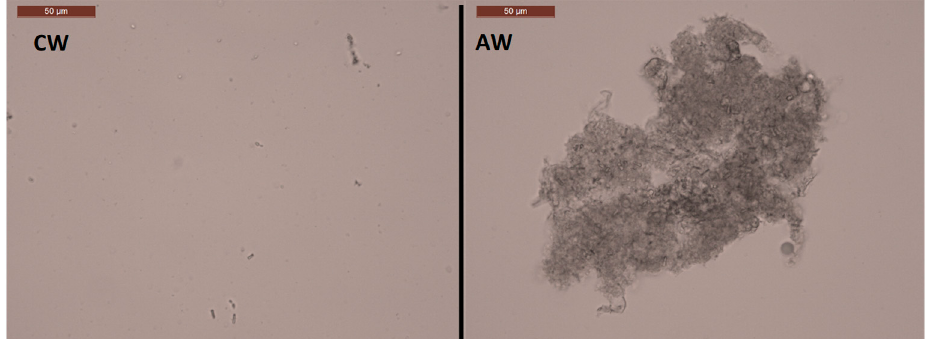
Figure 8. Example microscope pictures of non- and heat-treated wort: Left, control wort (CW); Right, autoclaved wort (AW).